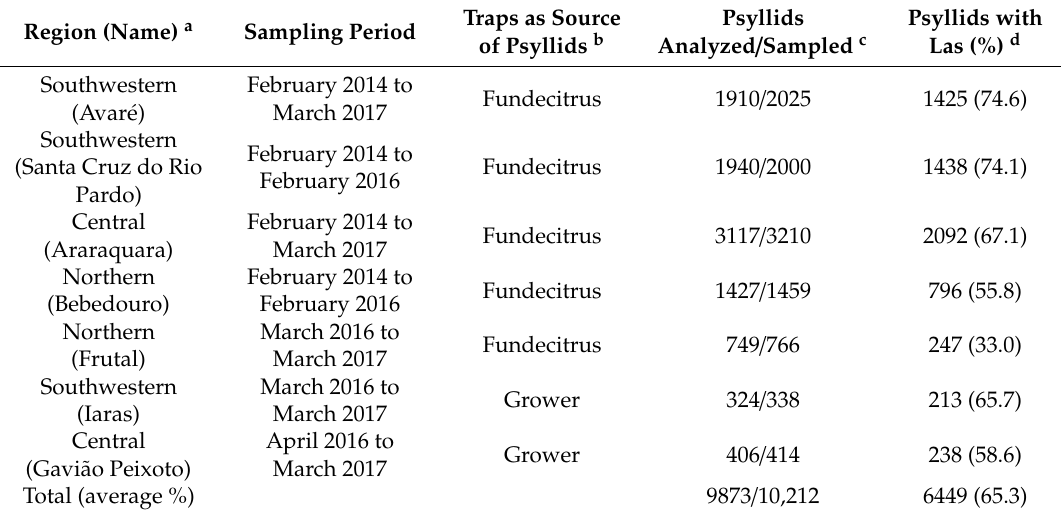
Table 1. Locations and period where yellow sticky traps were monitored for the presence of psyllids and sampled for Candidatus Liberibacter asiaticus